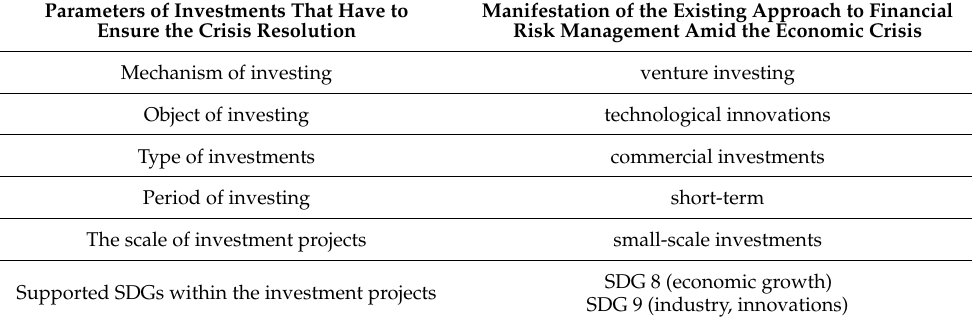
Table 1. The essence of investment according to the existing approach to financial risk management amid the economic